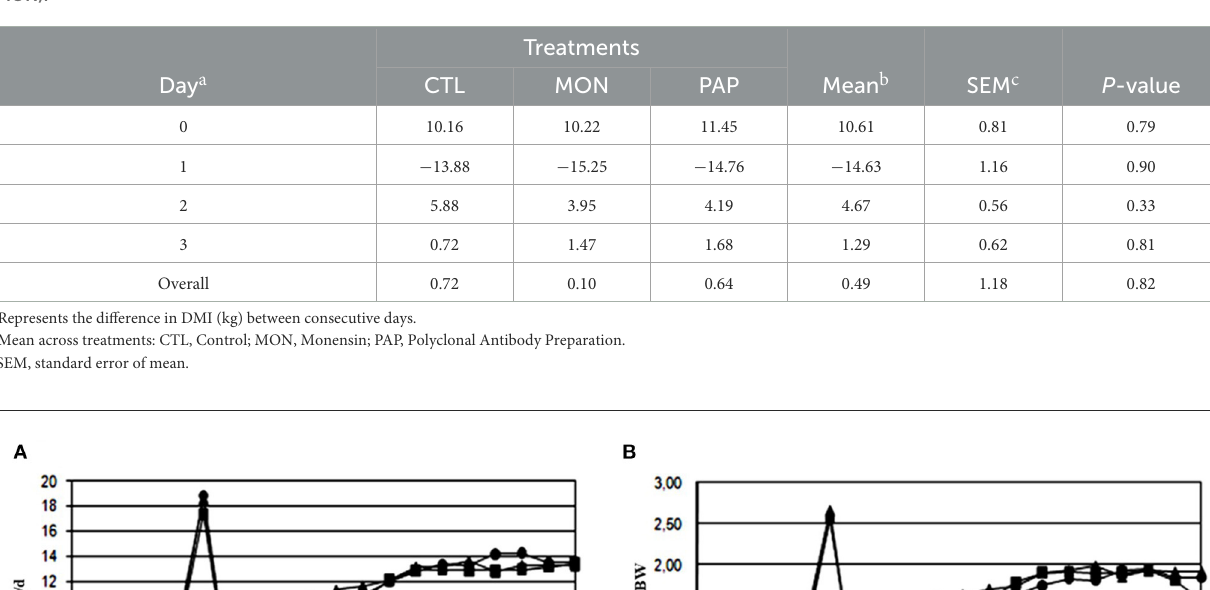
TABLE 3 Fluctuation in dry matter intake (DMIF, kg) of cows induced to ruminal acidosis receiving polyclonal antibody preparations (PAP) or monensin (MON).